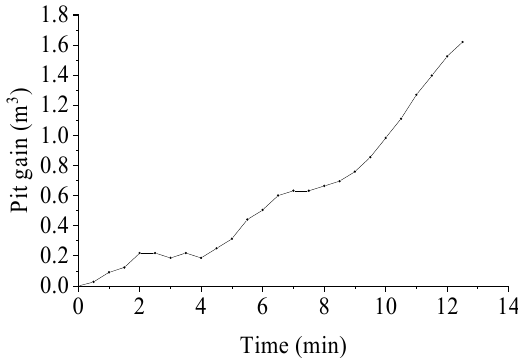
Figure 2. Time sequence diagram of pit gain.